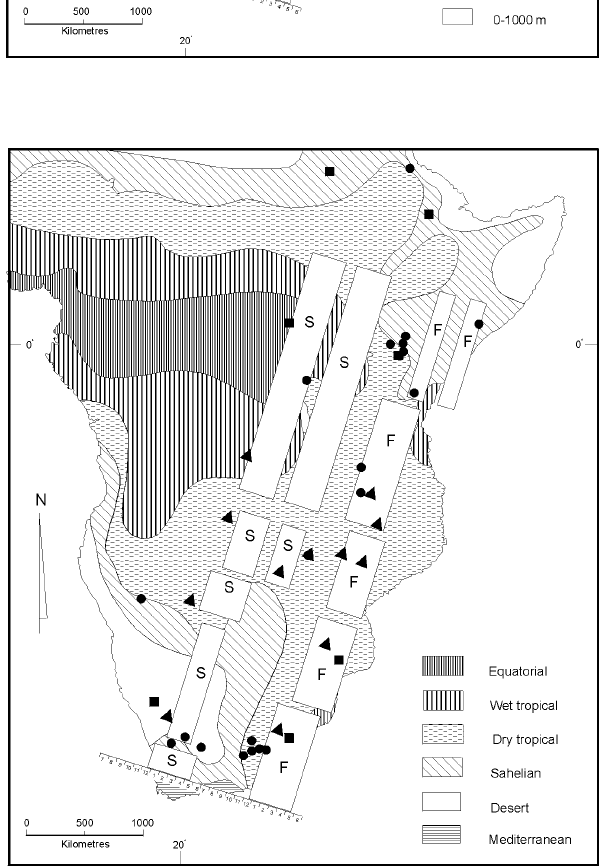
Figure 3 - Relief map of eastern Africa indicating areas (circles) of signifi- cantly high values of morphometric variance within the Apis mellifera scutellata populations. (Map modified from van Chi-Bonnardel, 1973). Tri- angles denote localised regions of high temperature changes, squares denote low temperature discontinuities. Principal reproductive swarming (S) and major flowering (F) periods of the relevant bee flora are indicated to the left and right of the vertical line, respectively. Horizontal scale units are months of the year beginning on both sides of the vertical line with July (month 7) and running through June (month 6) because July is mid-winter and the end of the annual colony cycles. The map is diagrammatic for swarming and flowering as they change with latitude.